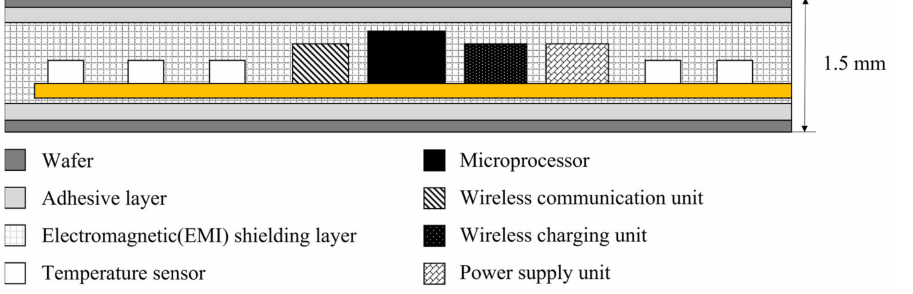
Figure 2. Structure of OTMS.